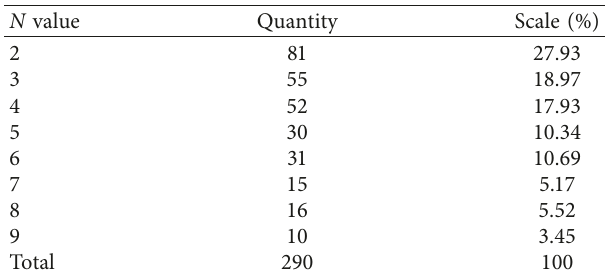
Table 2: Distribution ratio of candidate lexical chunks with N values of 2–9.